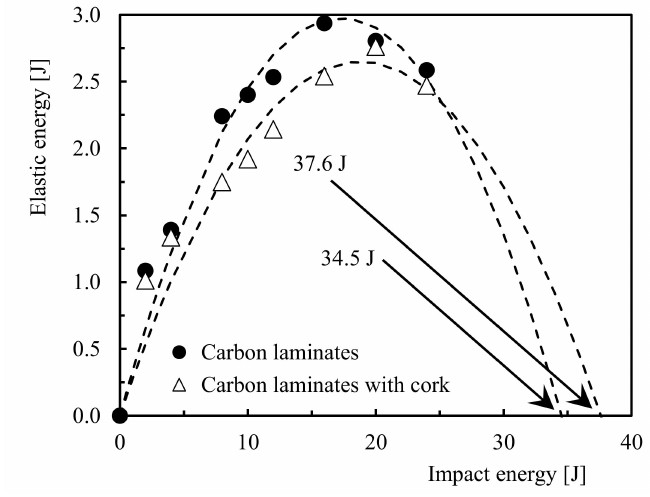
Figure 3. Penetration threshold for laminates with neat resin and matrix filled with cork powder.